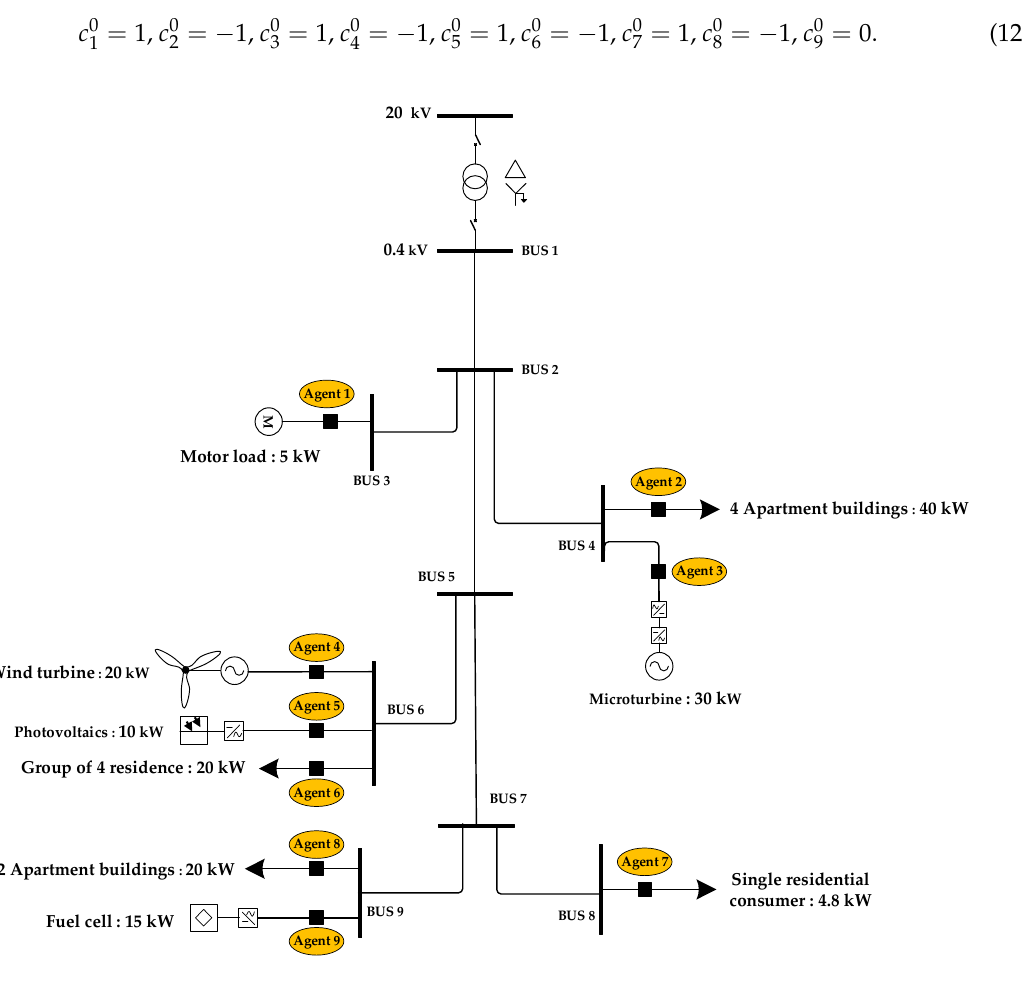
Figure 10. Benchmark LV MG network.